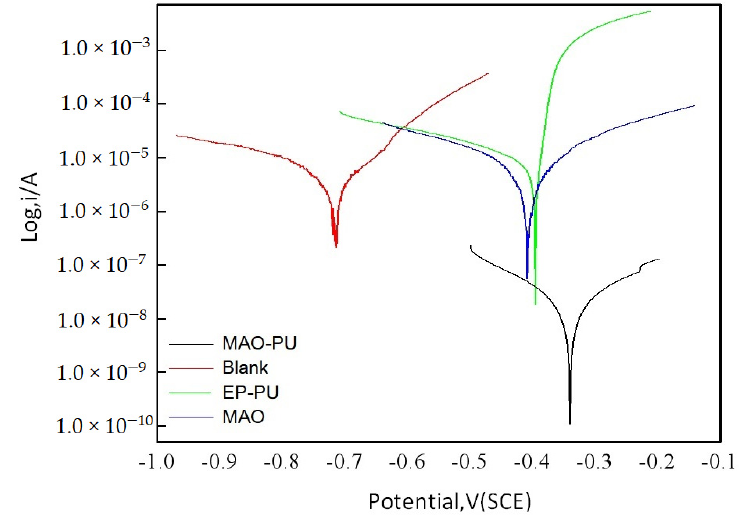
Figure 7. Electrochemical polarization curve test results.